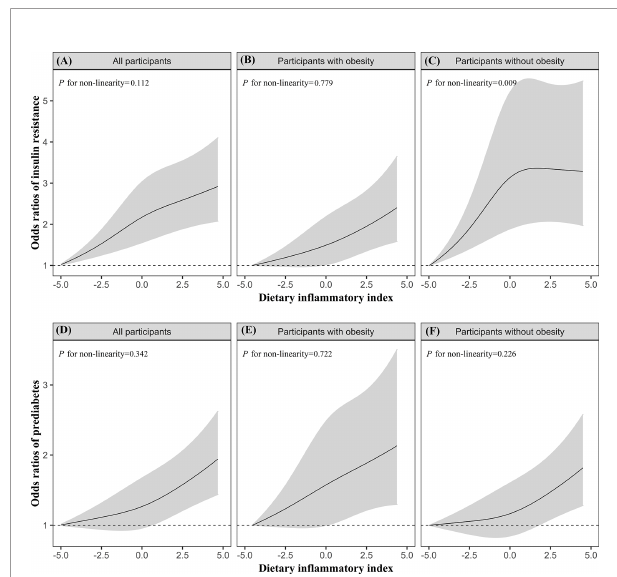
FIGURE 1 | The dose – response relationships of DII with IR (A – C) and prediabetes (D – F) in all participants, participants with obesity, participants without obesity. Results were from restricted cubic spline models. Models were adjusted for energy intake (continuous), age (continuous), sex (categorical), education levels (categorical), ethnicity/race (categorical), PIR (continuous), BMI (categorical, only for overall population), hypertension (categorical), CVD (categorical), cancer (categorical), serum cotinine (continuous), and physical activity